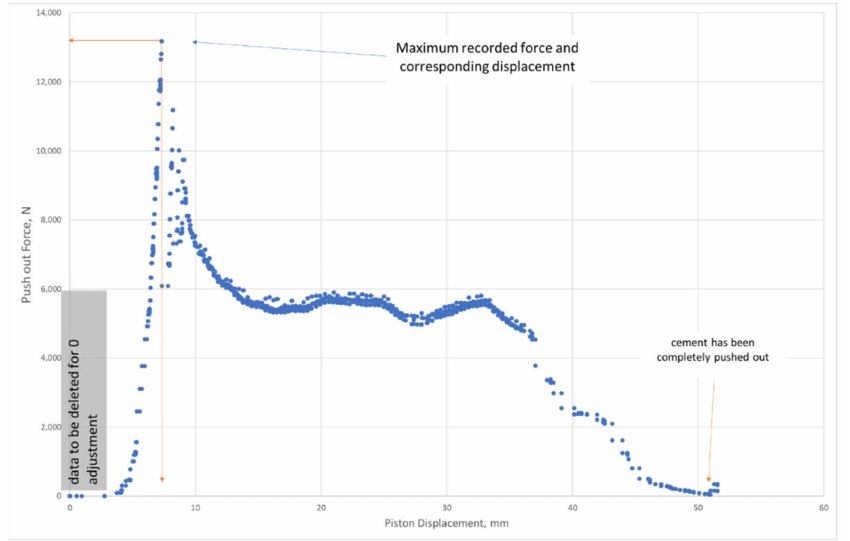
Figure 3. Recorded push-out force versus piston displacement used to extract and calculate the interfacial bonding shear strength.